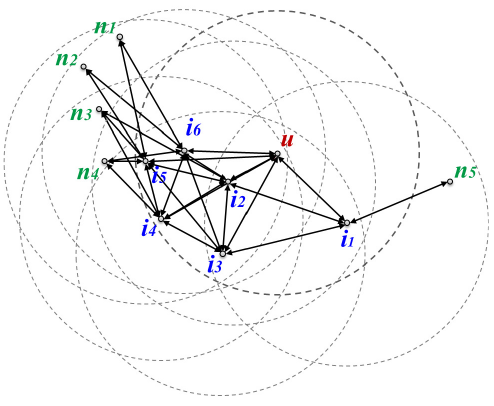
Figure 3. Beaconing: the exchange of position information between nodes.